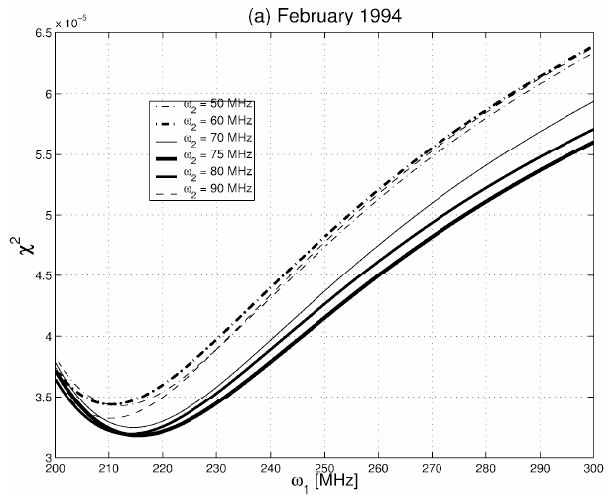
Fig. 5. χ 2 of the residual for different values of ω 1 and ω 2 for the baseline measured in February